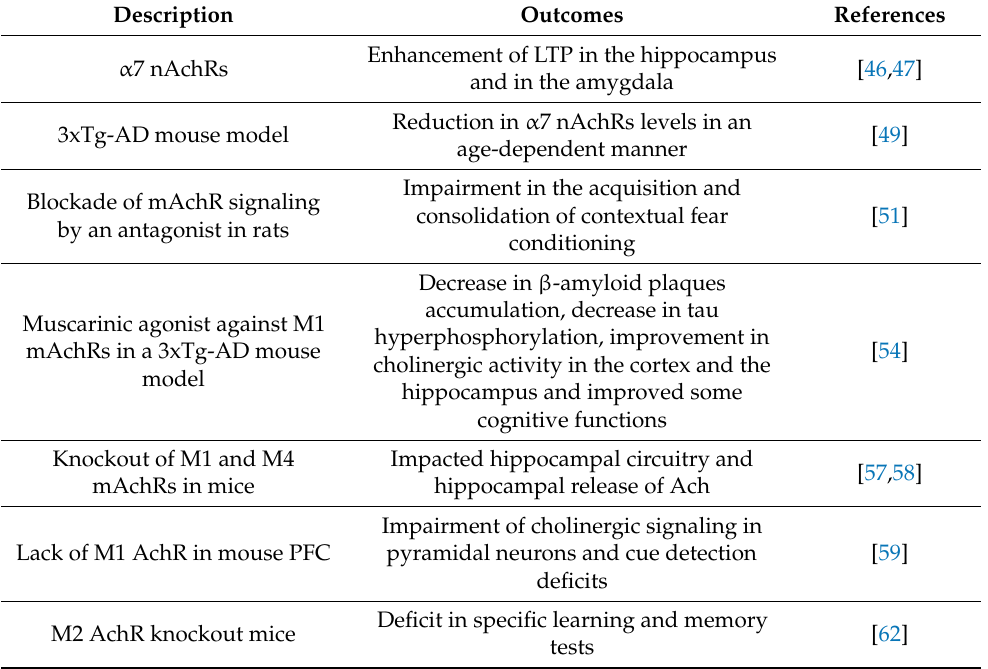
Table 1. Summary of the role of cholinergic receptors in the brain. The role of the cholinergic receptors such as nicotinic (nAchRs) or muscarinic (mAchRs) receptors in different brain regions of animal models is